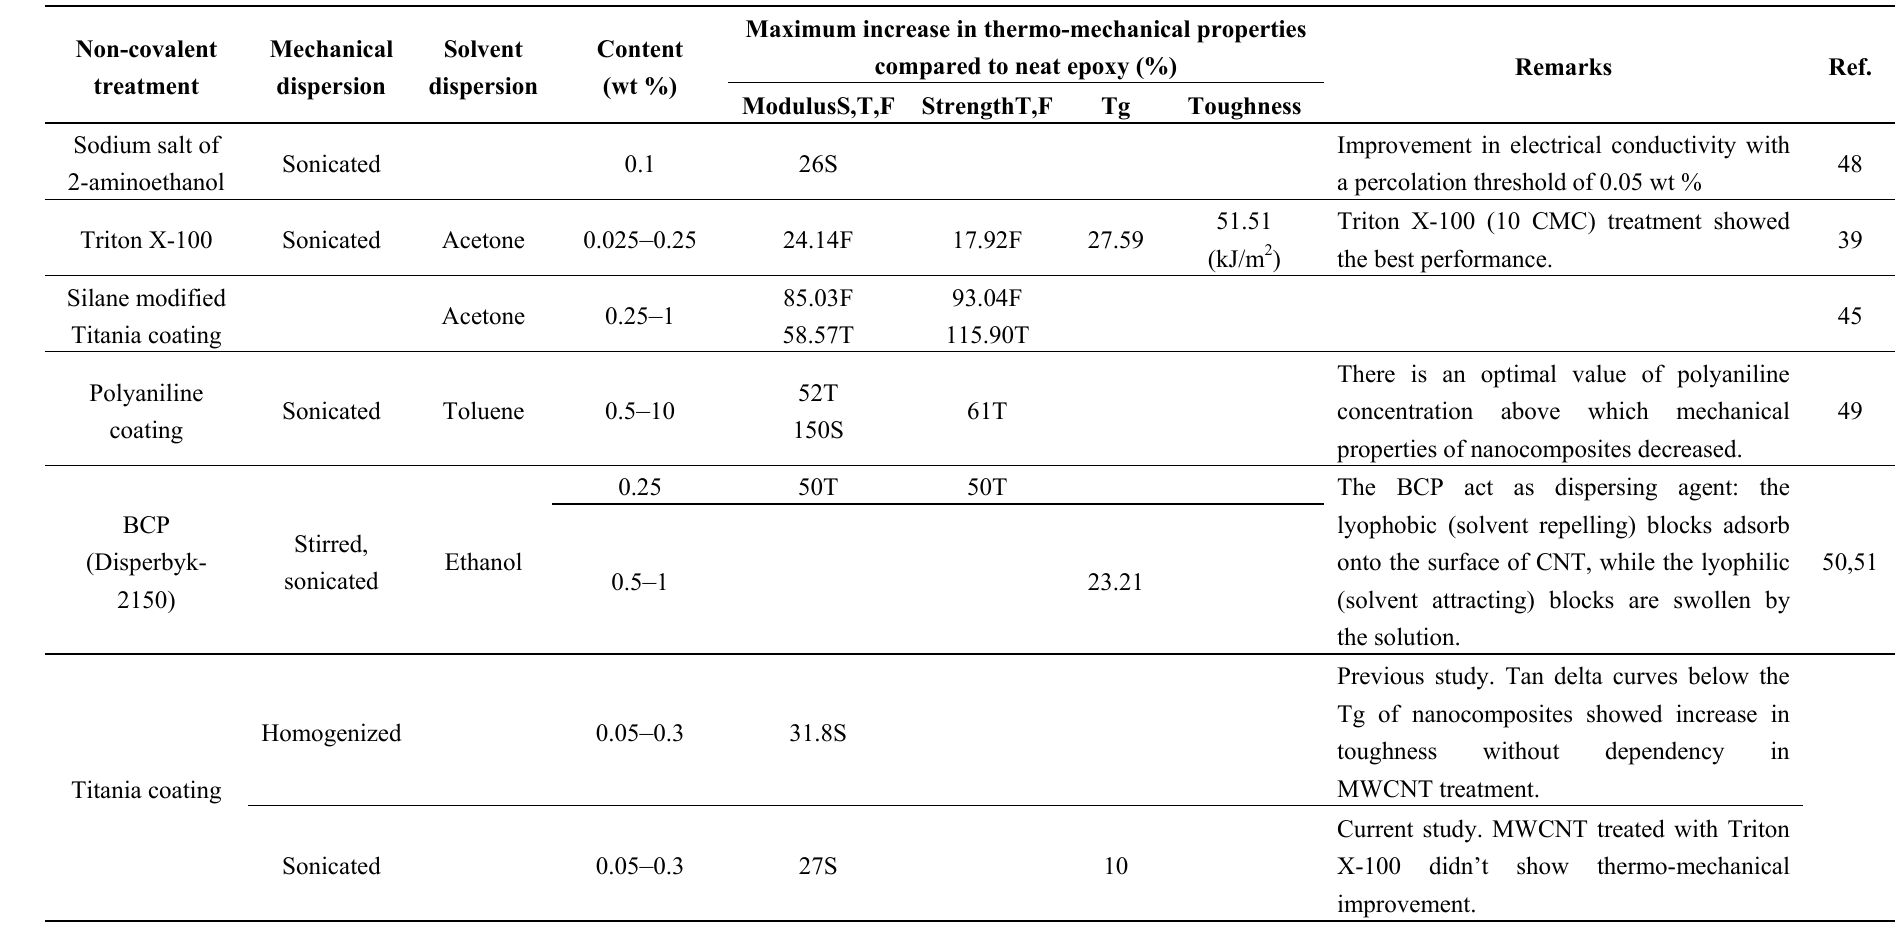
Table 2. Effect of non-covalent treated MWCNT on the thermo-mechanical properties of epoxy